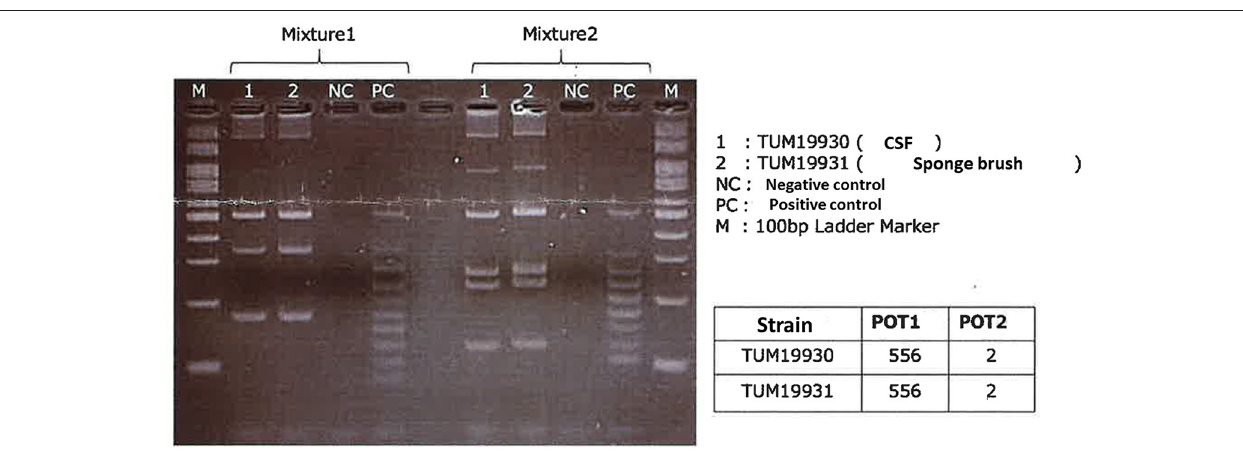
FIGURE 2 | Agarose gel electrophoresis patterns of the PCR-based open reading frame typing (POT) using the Cica Geneus Pseudo POT KIT. PCR of reaction mixtures 1 and 2 was carried out for strain 1 and 2. Lane 1: strain 1 obtained from the patient’s cerebrospinal fluid. Lane 2: strain 2 obtained from a cleaning sponge brush. The sizes of the bands in the M lane are 600, 500, 450, 400, 350, 300, 250, 200, 150, and 100 bp (from the top). PC, positive control; NC, negative control, used as an in-house ladder marker for detection PCR of Pseudomonas aeruginosa . Lines 1 and 2 showed the same band patterns, and the POT numbers of both strain 1 and 2 were the same values. The results from POT 1 and 2 values indicated these strains did not carry a metallo-beta-lactamase, such as IMP and VIM. from CSF according to agarose gel electrophoresis patterns of the PCR-based open reading frame typing (POT) study (5,